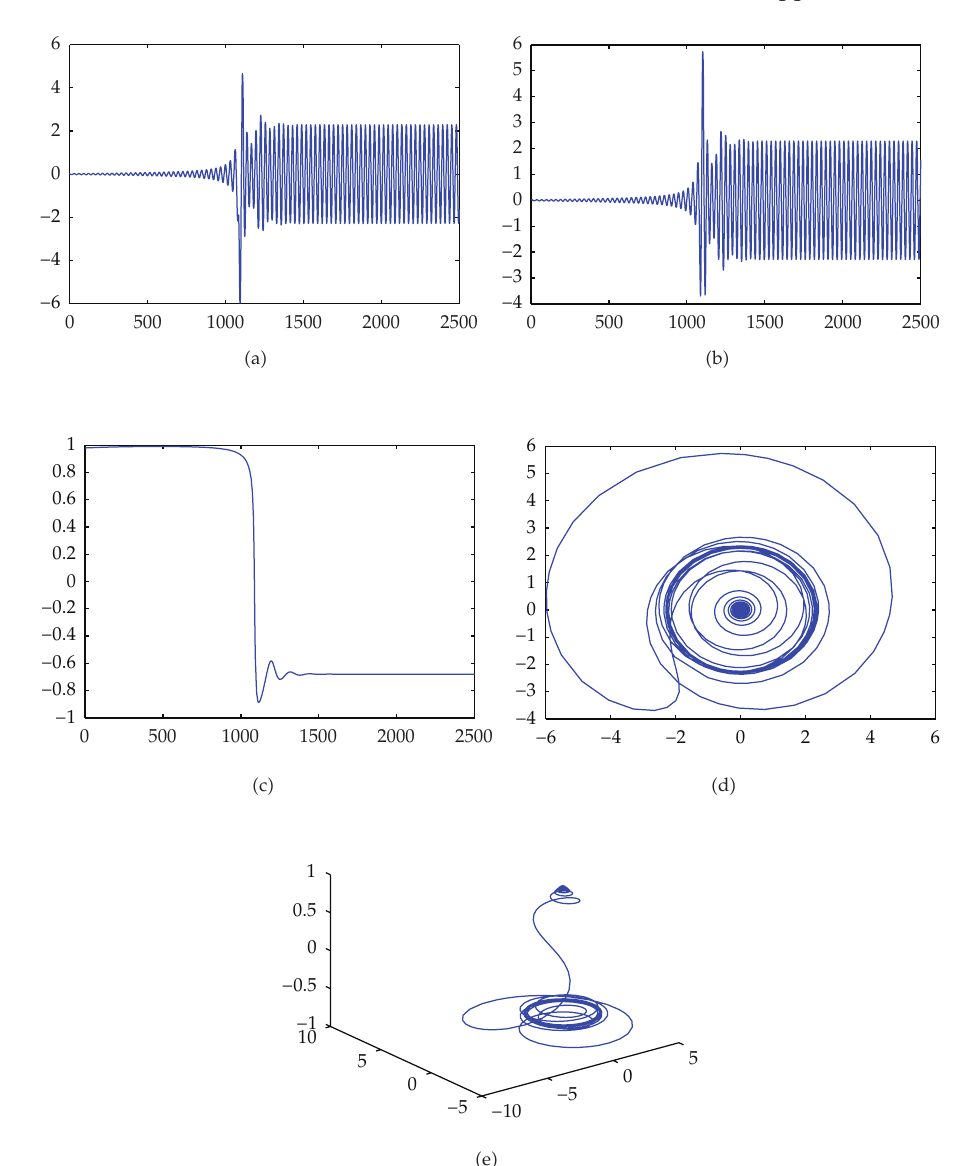
Figure 1: For system (cid:2) 1.4 (cid:3) with the data (cid:2) A (cid:3) , the Hopf bifurcation is backward at the first critical value . (cid:7) 0 . 5448, and the bifurcating periodic solutions are asymptotically stable, where τ (cid:7) 0 . 54 < 0 . 5448 and τ − 0 the initial value is taken as (cid:2) 0 . 01 , 0 . 01 , 0 . 98 (cid:3)